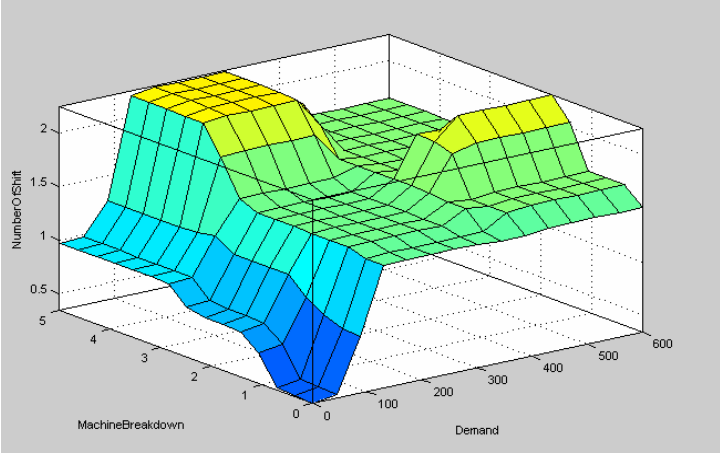
Figure 8. “Surface Analysis between Demand and Machine Breakdown with Number of Shift”.